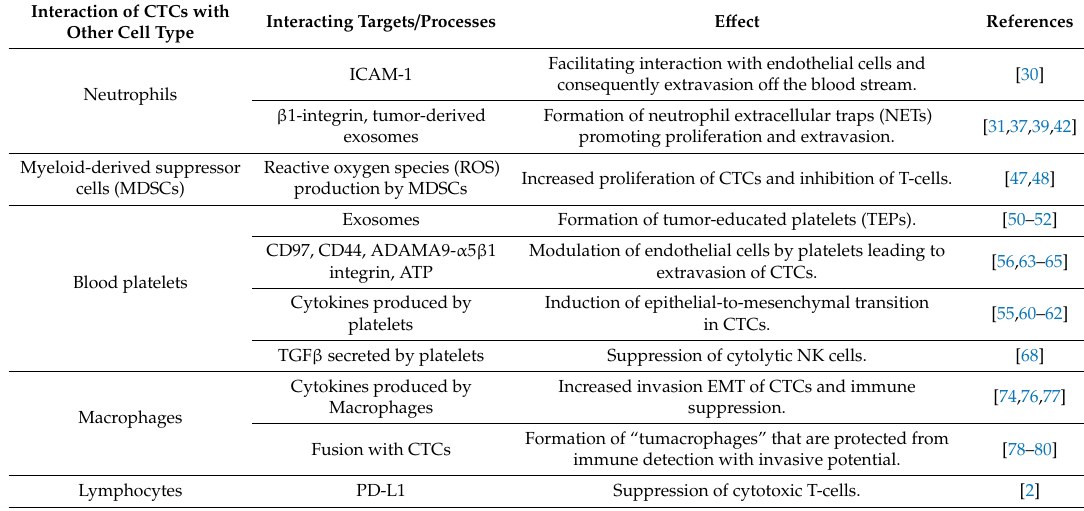
Summary of interactions of circulating tumor cells with other cell types in the blood